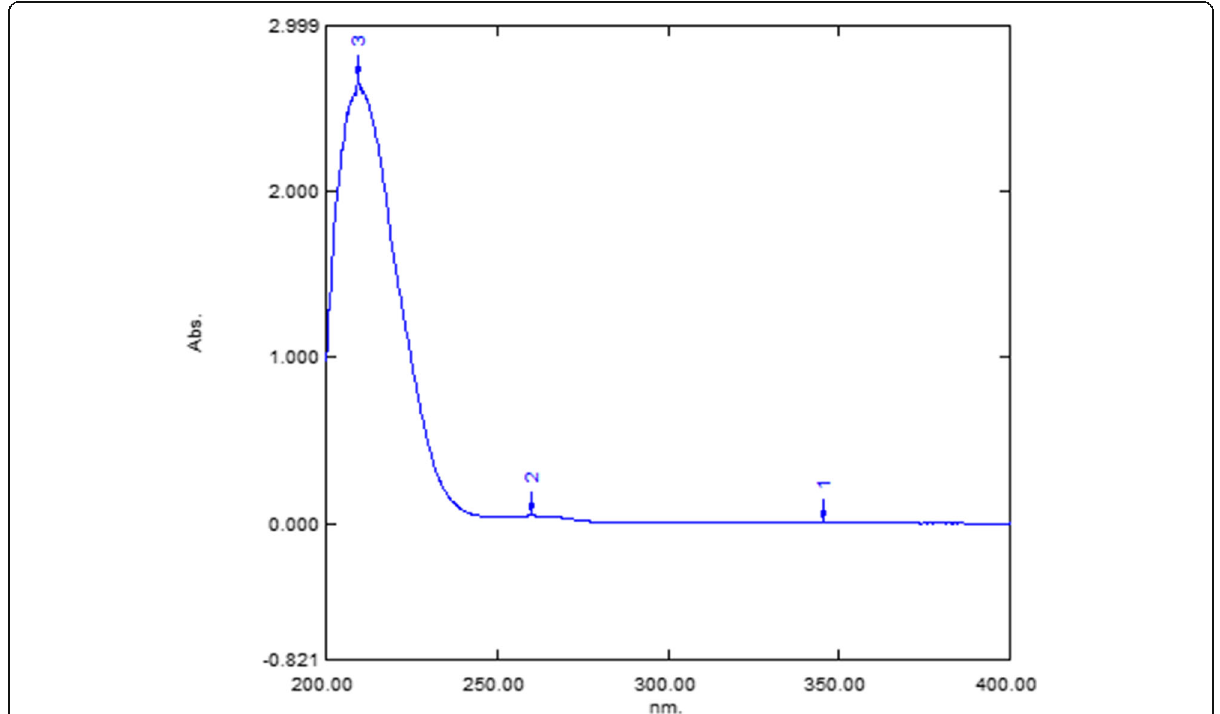
Fig. 2 UV spectrum of clotrimazole